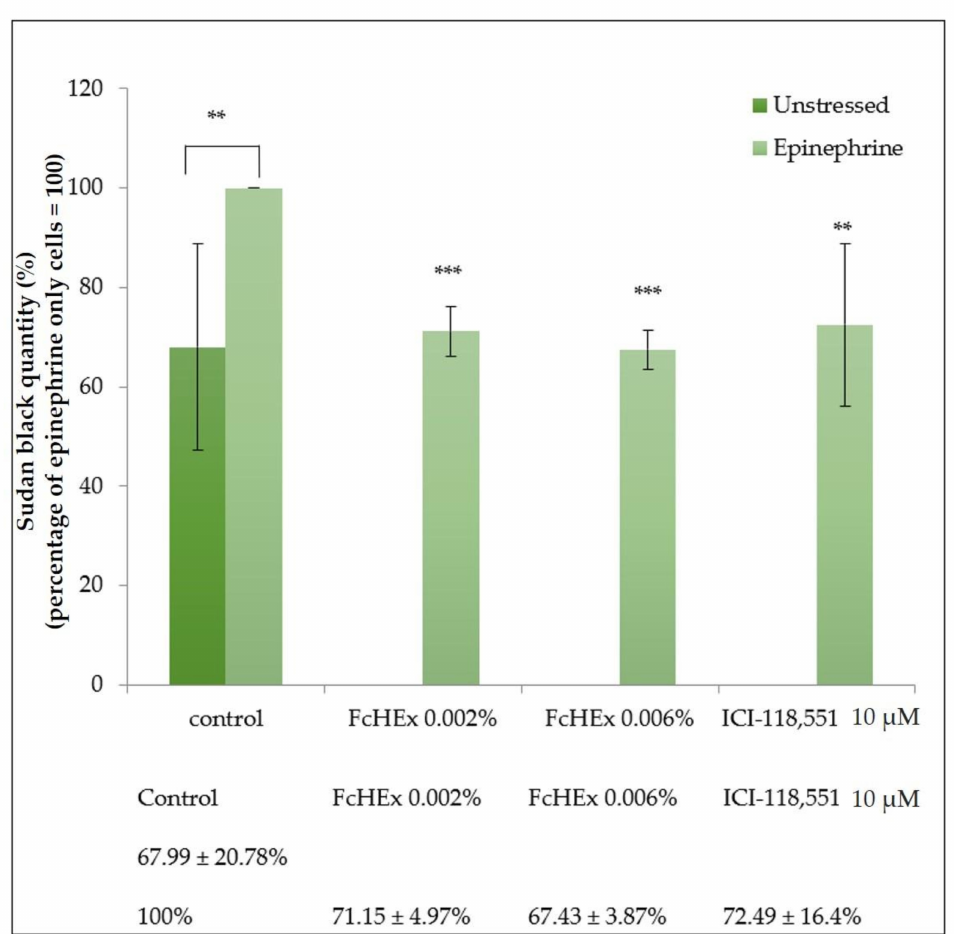
Figure 6. Effect of the FcHEx on the lipofuscin accumulation in the skin keratinocytes. The keratinocytes were treated with the FcHEx or the positive control for 24 h, then 50 nM of epinephrine was added to the cells incubated for an additional 48 h. At the end of the incubation, the cells were stained and the absorbance at 595 nM was measured. The obtained values were normalized relative to the protein content determined using a Bradford assay. The reported values represent the averages of three independent experiments and are expressed as the percentages of cells treated with epinephrine only, which was set to 100%. The asterisks indicate statistically significant values (*** p -value was between 0.0001 and 0.001; ** p -value was between 0.001 and